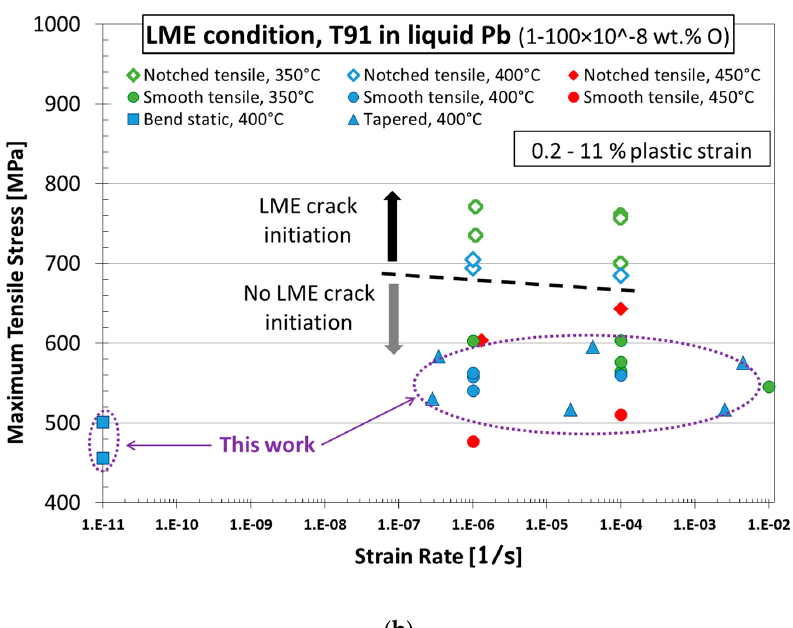
Figure 12. Summary test condition of T91 in liquid Pb mapping LME occurrence. Maximum applied tensile stress in relation to ( a ) maximum total plastic strain and ( b ) strain rates: Data of CERT and static exposure tests with four specimen types (smooth and notched tensile, tapered, and three-point bend) at three temperatures showing the LME area of occurrence [13,14]. Note that LME appeared only in notched tensile specimens at 350 and 400 °C if extremely high stress, over Rm, was applied. This work’s results are highlighted by the dashed-line circle.